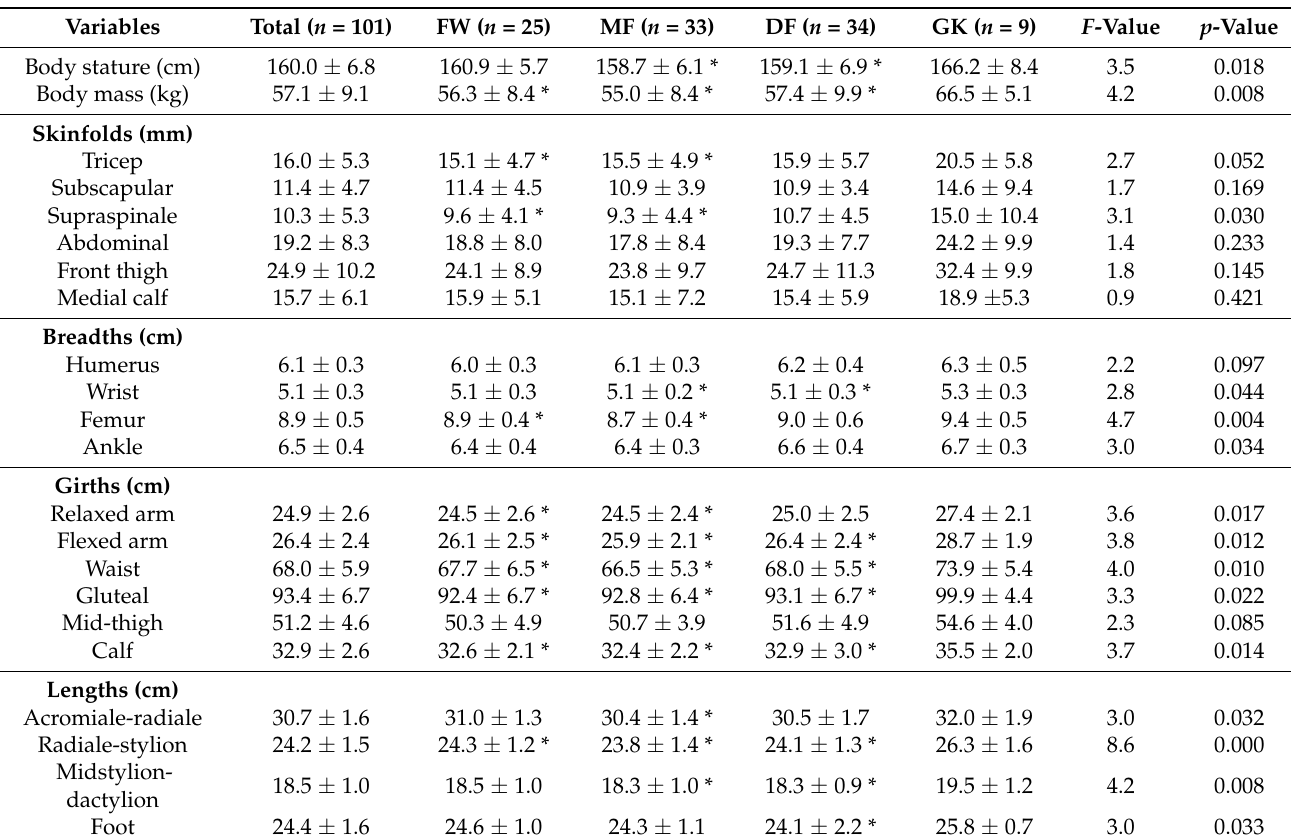
Table 1. Morphological characteristics of sub-elite female football players by playing position (mean ±